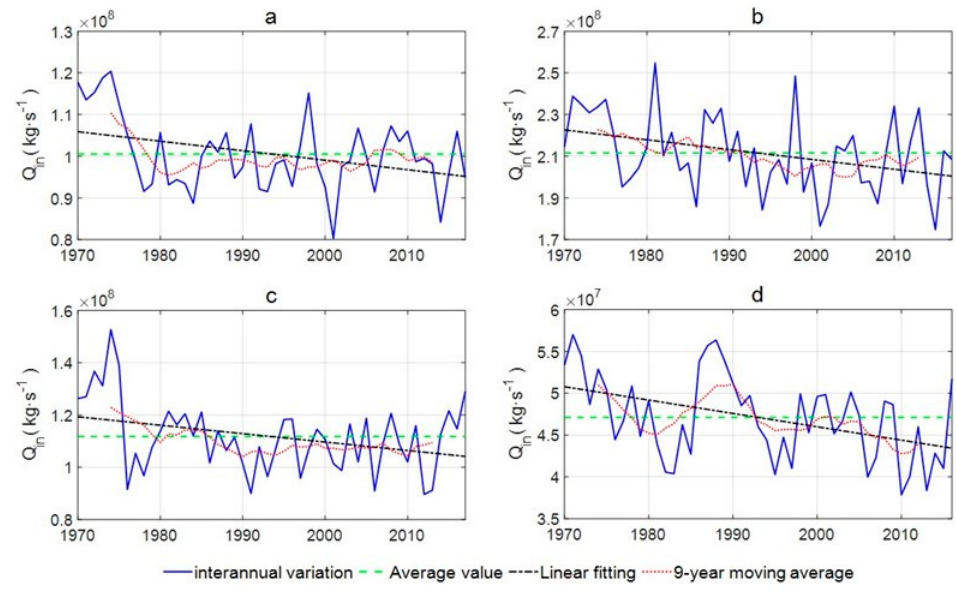
Figure 7. Interannual variation of water vapor input (Qin) in SAIE (semi-arid inland Eurasia) from 1970 to 2017 in ( a ) spring, ( b ) summer, ( c ) autumn, and ( d ) winter.